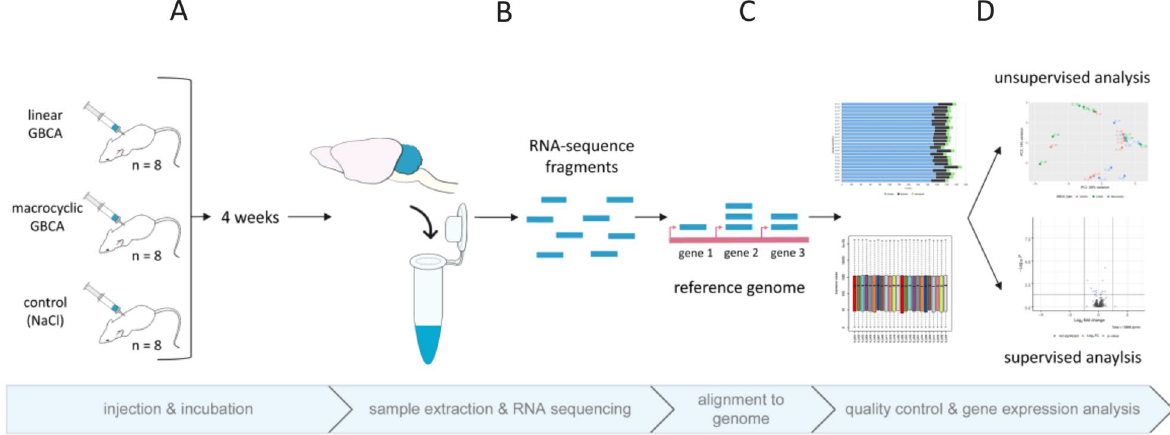
Figure 1. Study design of gene expression analysis. Three groups of mice were injected with either linear GBCA, macrocyclic GBCA or saline ( A ). After four weeks, mice were sacrificed and RNA from whole cerebella was extracted and sequenced ( B ). The resulting RNA fragments were aligned to the mouse reference genome ( C ). Quality controls of RNA sequences were performed to ensure unbiased analysis of high-quality data. Gene expression analysis was performed in unsupervised and supervised form ( D ). Unsupervised analysis by principal component analysis (PCA) was conducted to compare the whole gene expression between samples. In the supervised analysis gene expression profiles were compared between treatment groups to identify up- or downregulated